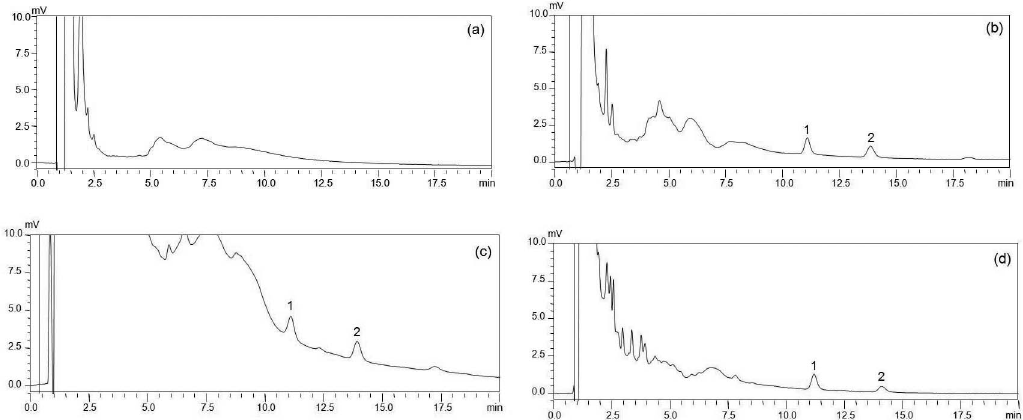
FIGURE 4 - Representative chromatograms of blank plasma (a), plasma spiked with hydroxydihydrobovolide and IS (b), plasma sample 8 min after the intravenous administration (c) and oral administration (d) of hydroxydihydrobovolide. Peak 1: IS; Peak 2: hydroxydihydrobovolide. TABLE II - Precisions, accuracy and recovery of hydroxydihydrobovolide in rat plasma and recovery of hydroxydihydrobovolide in rat